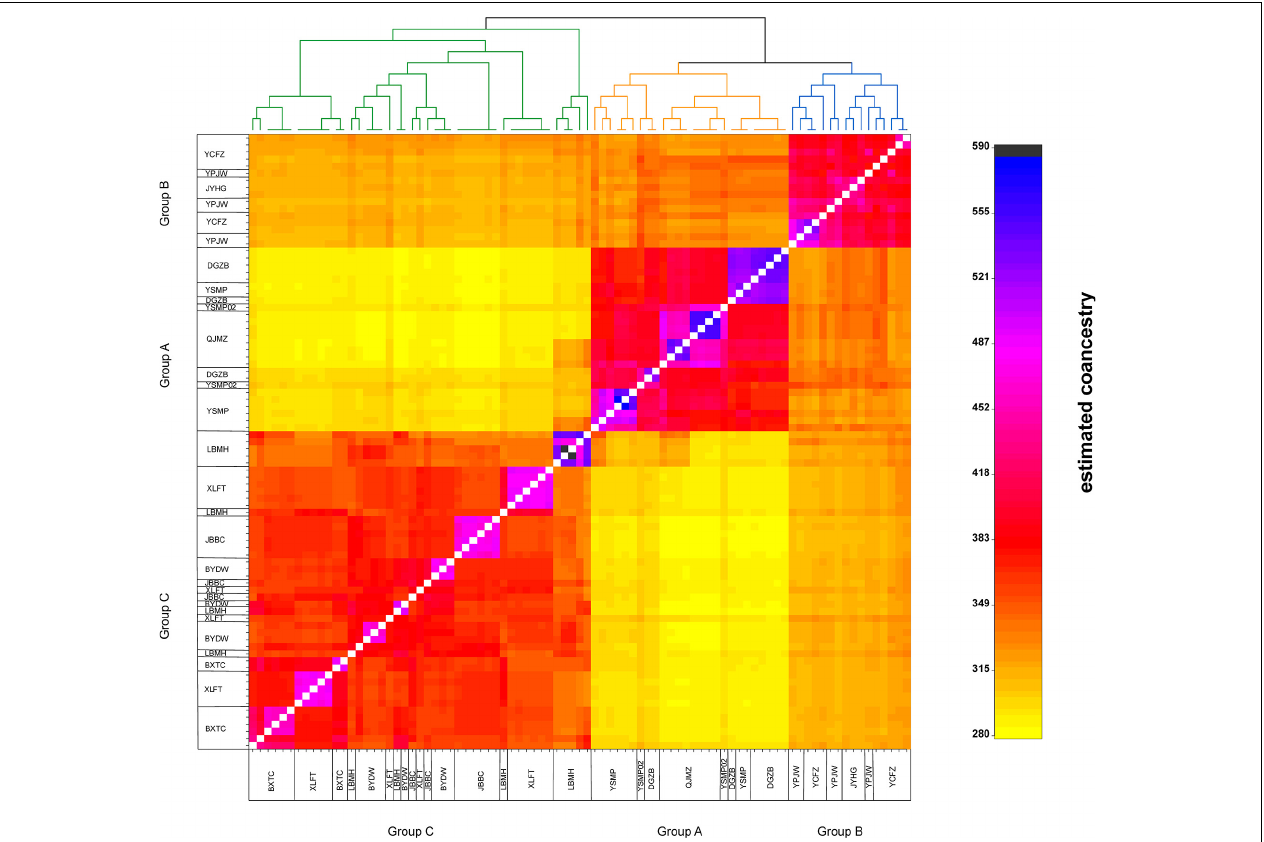
FIGURE 3 | The clustered co-ancestry matrix of Amorphophallus albus germplasms by fineRADstructure, indicating pairwise co-ancestry between individuals.